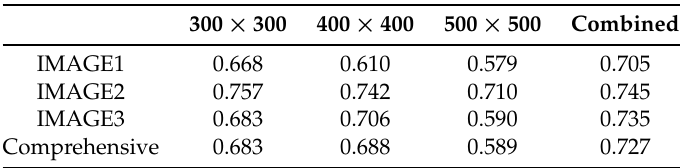
Table 7. Performance comparison of using each single cutting size and using the multi-scale detection strategy (combined) on the testing set in terms of